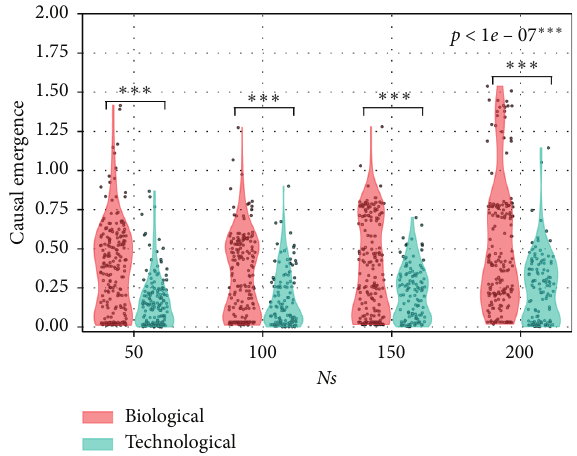
Figure 6: Propensity for causal emergence in real networks. Growing snowball samples of the two network domains that previously showed the greatest divergence in effectiveness : tech- nological and biological networks. At each snowball size, N s , each network is sampled 20 times. Across these samples, the total amount of causal emergence for a given sample size is significantly different between the two domains ( t -test, comparison of